Question: Give a one-sentence summary of this figure.
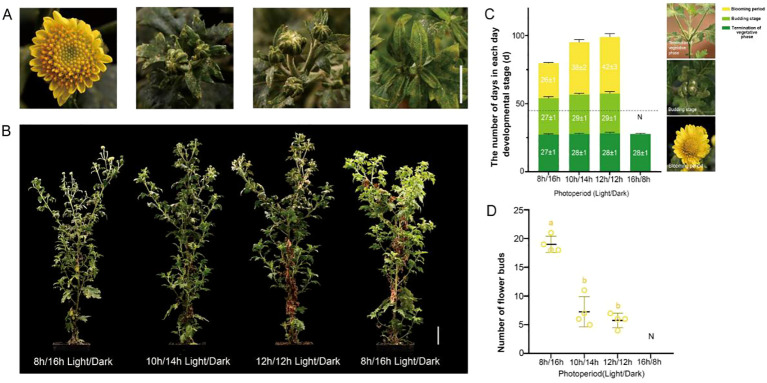
Answer: Phenotypic characteristics of ‘Xiaokuixiang’ under different photoperiods. (A,B) Flowering phenotypes (A) and growth morphology (B) , scale bar = 1 cm (A) and 5 cm (B) . (C) Growth stage; dotted lines indicate the start of the transition from long-day treatment to different photoperiod treatments. (D) Number of normally opening flower buds.